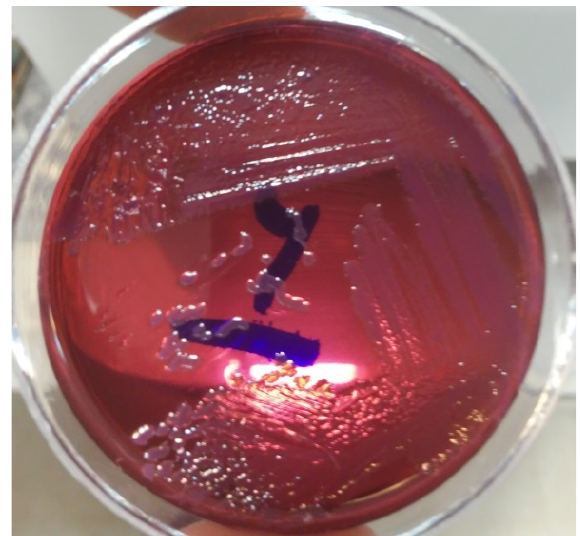
Fig.2 Grown colonies on EMB medium